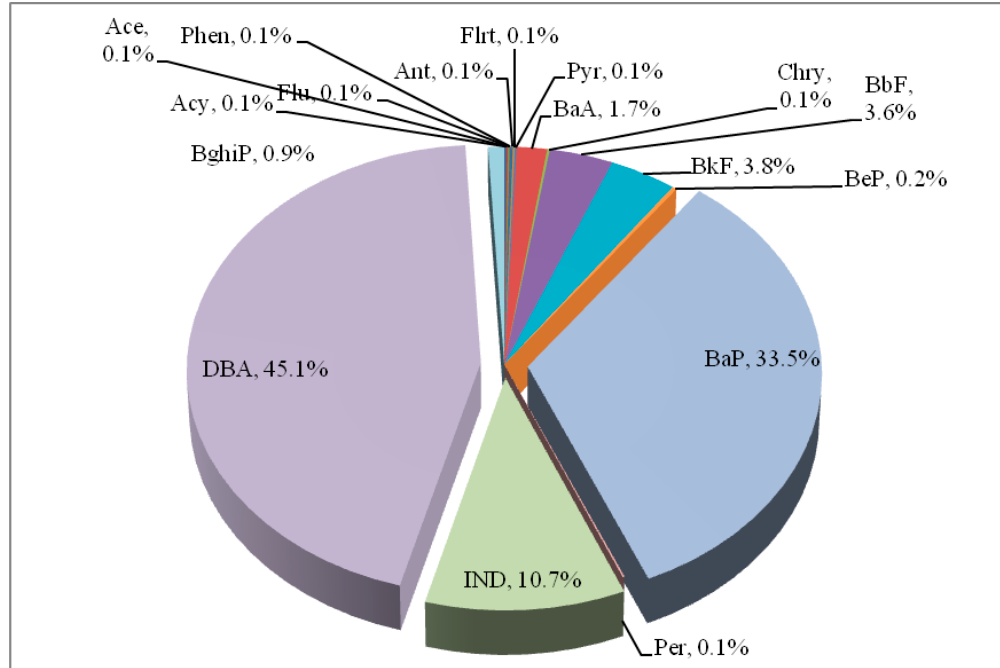
Figure 1. Proportions of BaPeq among the p-PAH components.